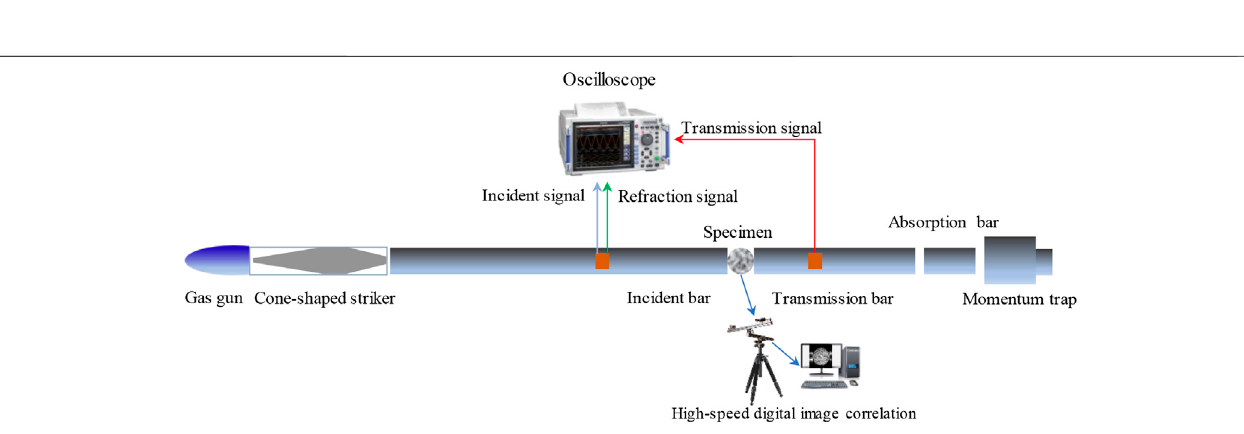
Frontiers in Physics |